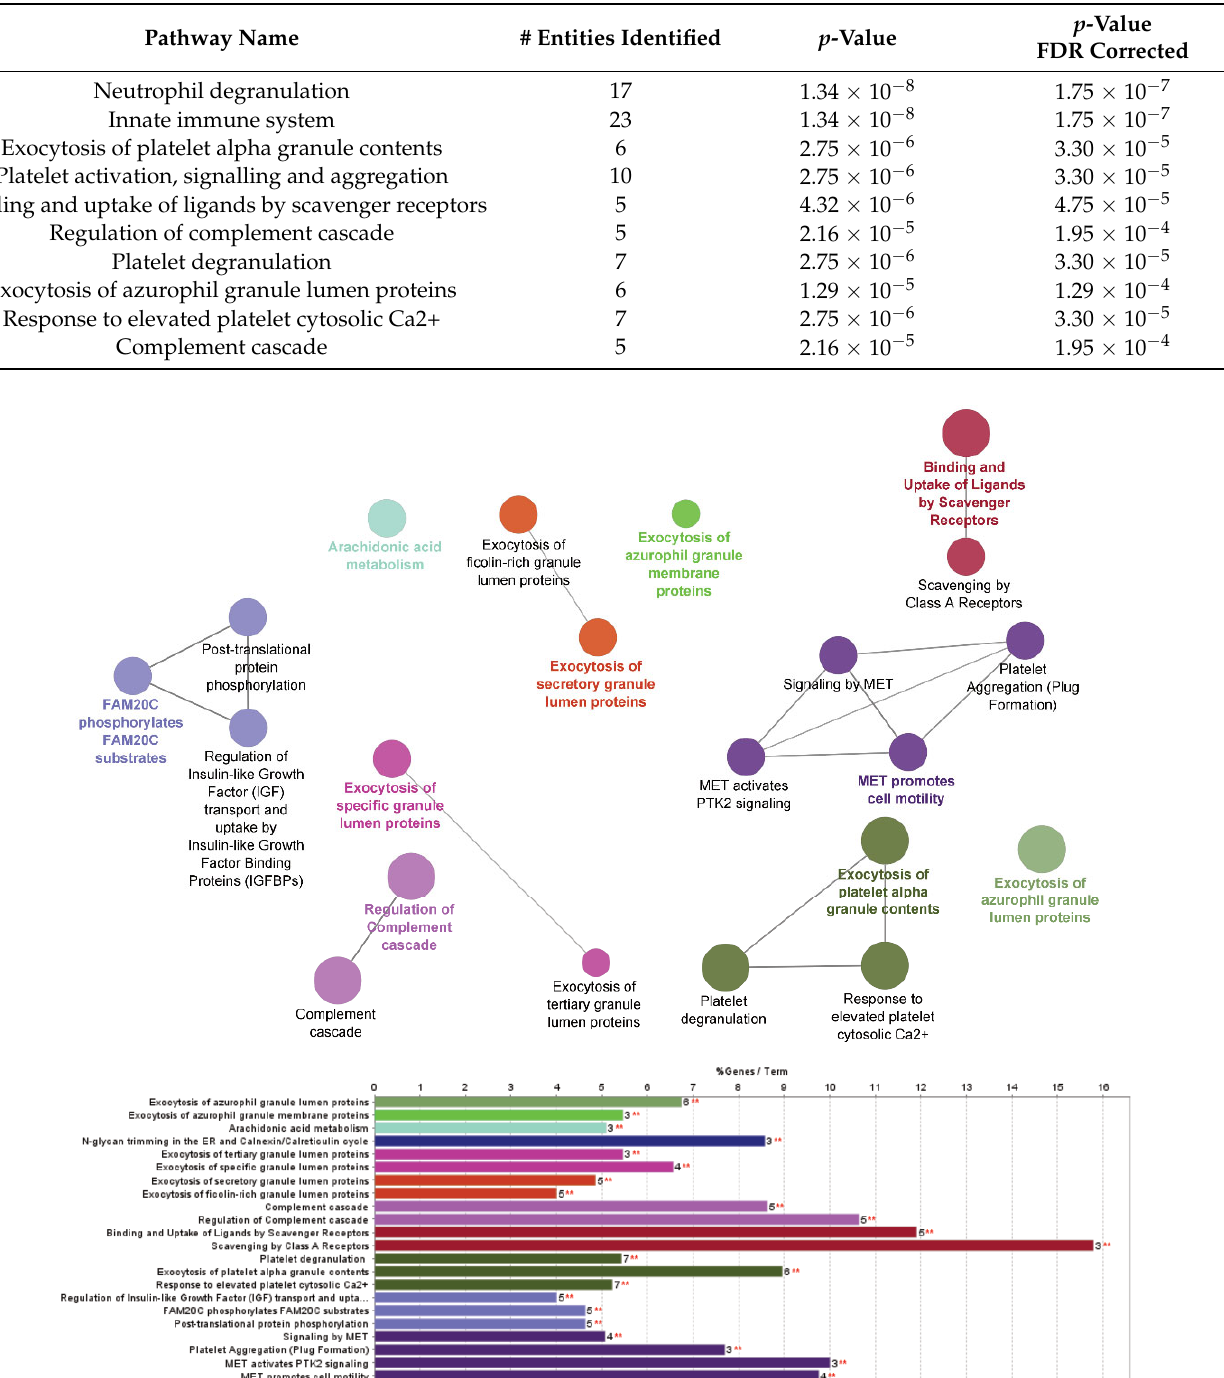
Table 5. Proteomics: pathways identified as differentially expressed between COVID-19-positive participants treated with glucocorticoids and those not treated with glucocorticoids.